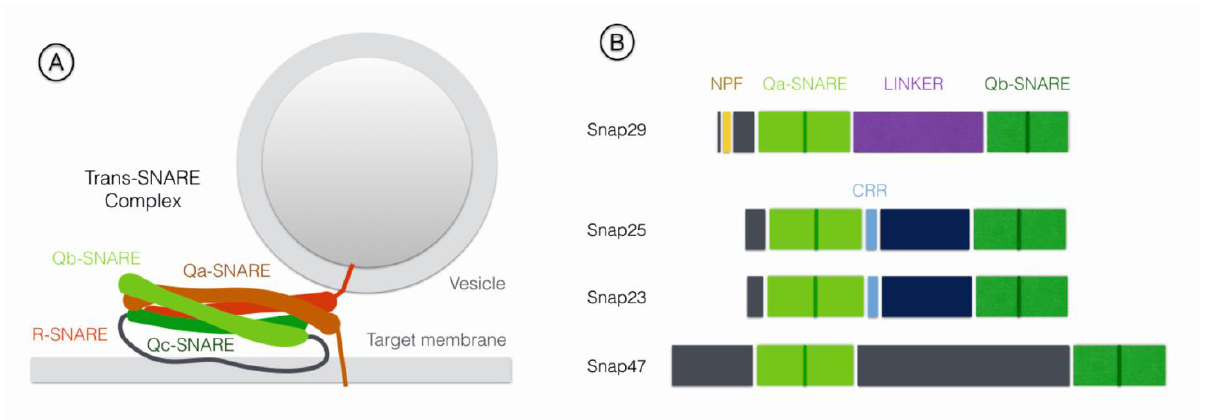
FIGURE 1 : Illustration of the trans-SNARE complex involved in membrane fusion. All SNARE domains are oriented with the N-termini to the left (A) . Schematic representation of SNAP family members in mammals (B) . The homologous SNARE domains among the 4 paralogs are shown. The position of the central glutamine residue (Q) is indicated by a line. The linker region of Snap29 is (purple) differs from that of other family members and does not contain a cysteine rich region (CRR; light blue) for membrane targeting.The N-Terminal acidic NPF motif, exclusive to Snap29 among family members, is shown in